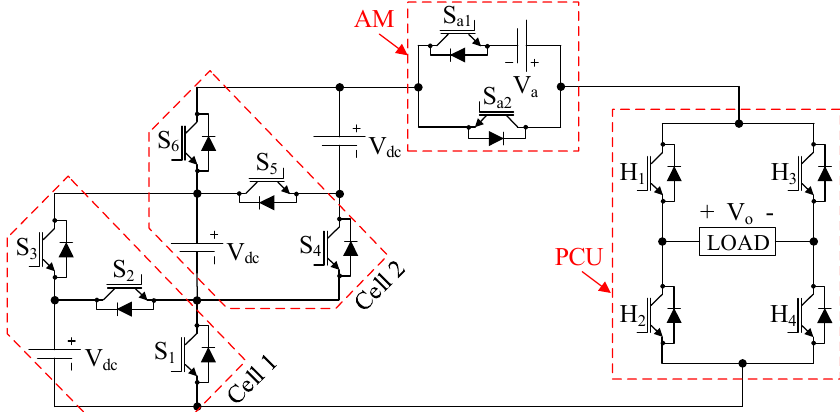
Figure 5. The proposed MLI topology with two cells. Table 1. Switching table with two cells.